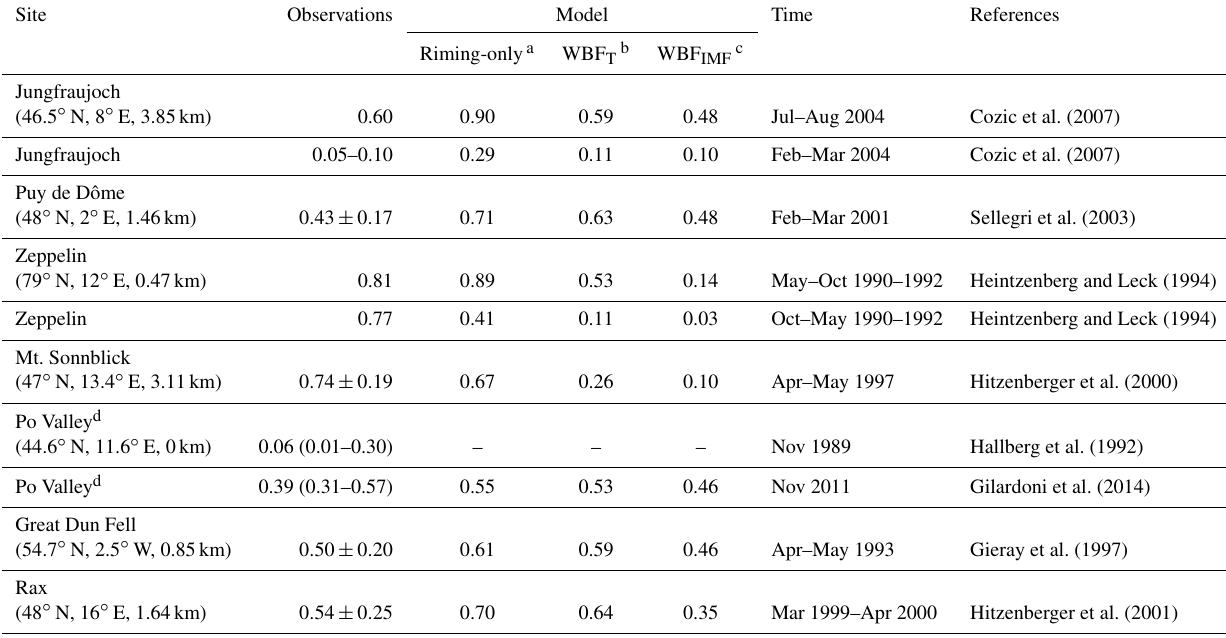
Table 1. Observed and GEOS-Chem-simulated scavenging efficiency of BC (fraction of BC incorporated into cloud droplets and ice crystals).